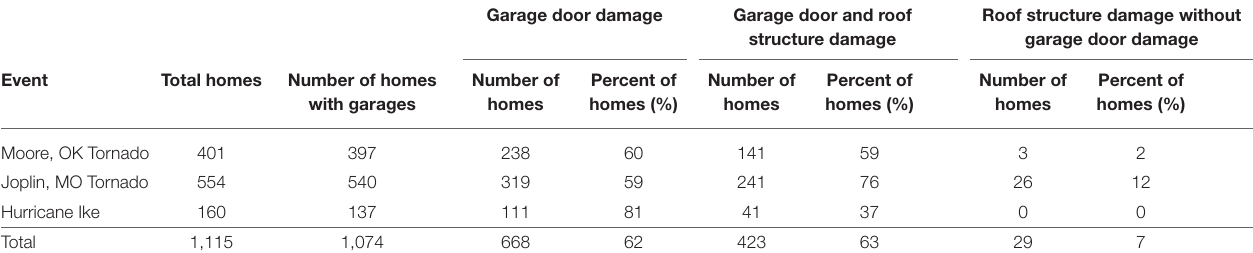
TABLE 1 | Damage rates for the three events